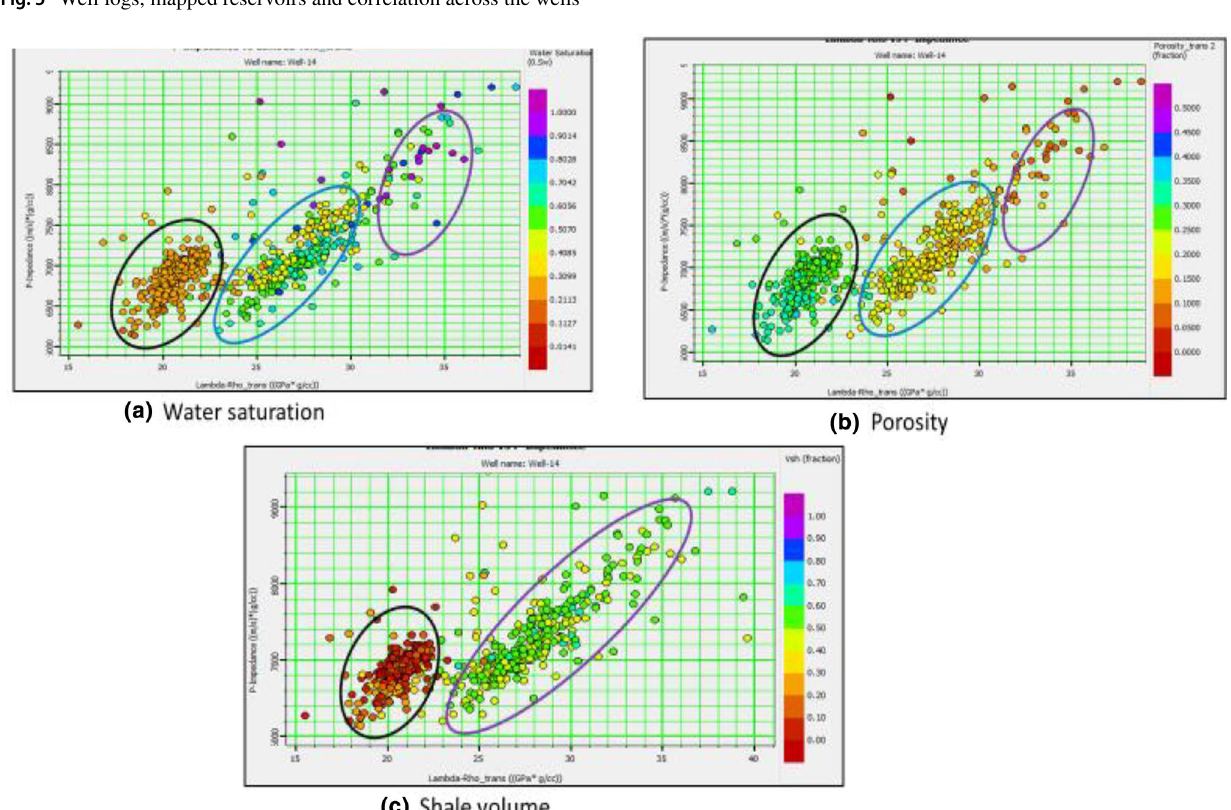
Fig. 6 Cross-plots of acoustic impedance ( I λρ ), color coded with a water saturation, b porosity and c shale volume p ) versus lambda–rho (